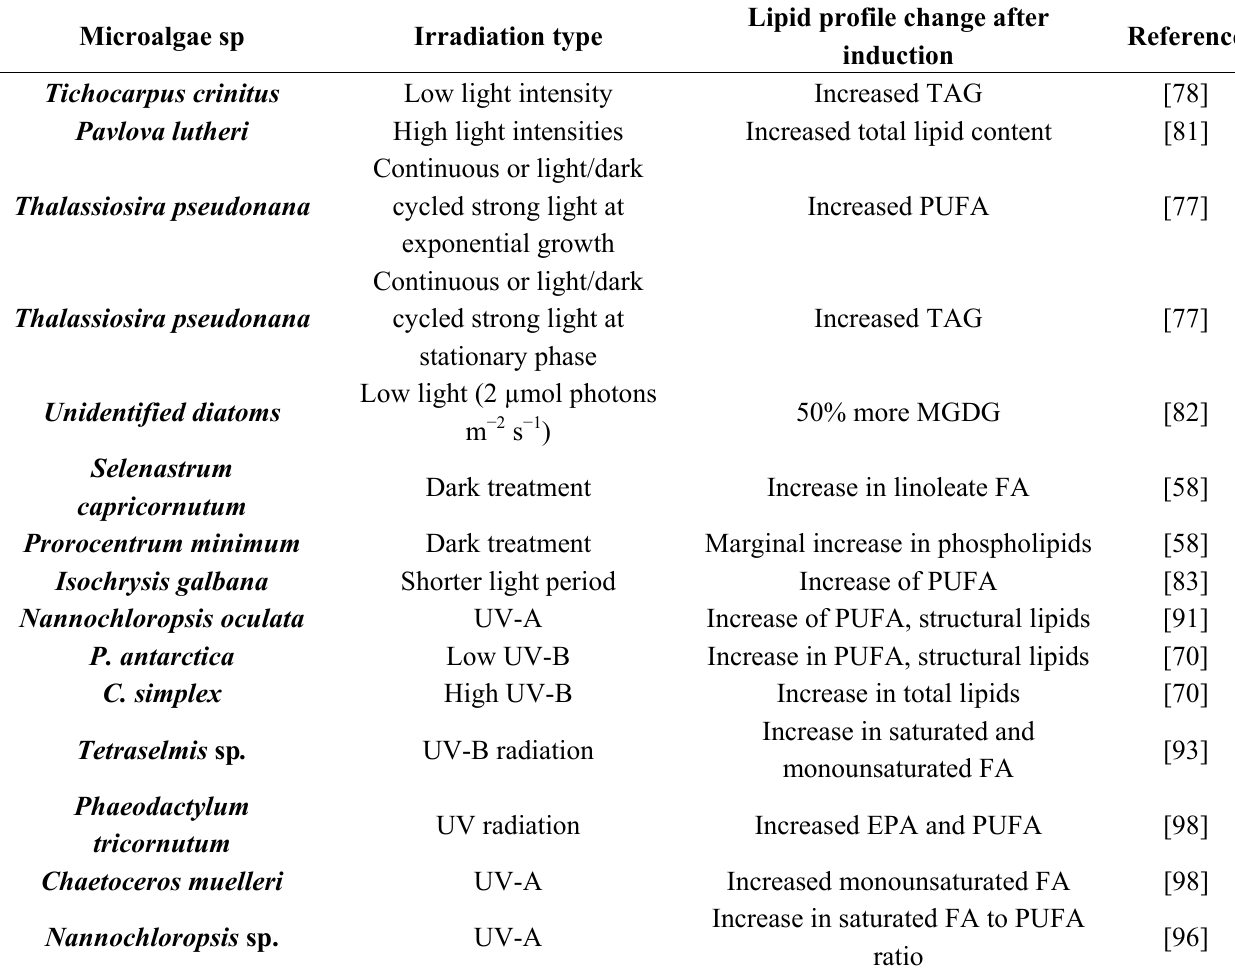
Table 4. Lipid induction due to different light irradiation stress in